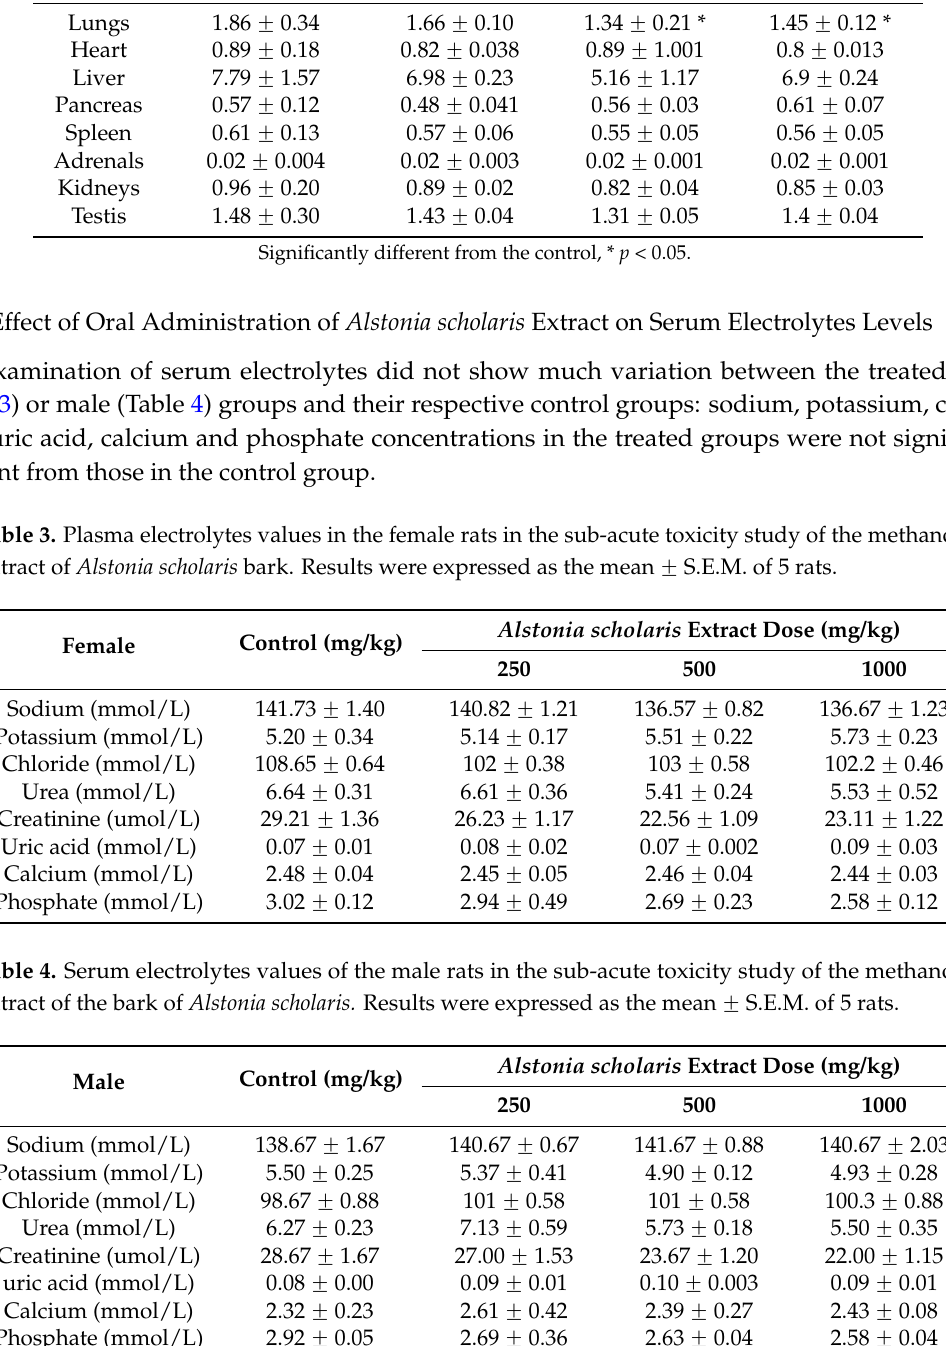
Table 2. Organ weights (g) of the male rats in the sub-acute toxicity study of the methanolic extract of Alstonia scholaris bark. Results were expressed as the mean ˘ S.E.M. of 5 rats.